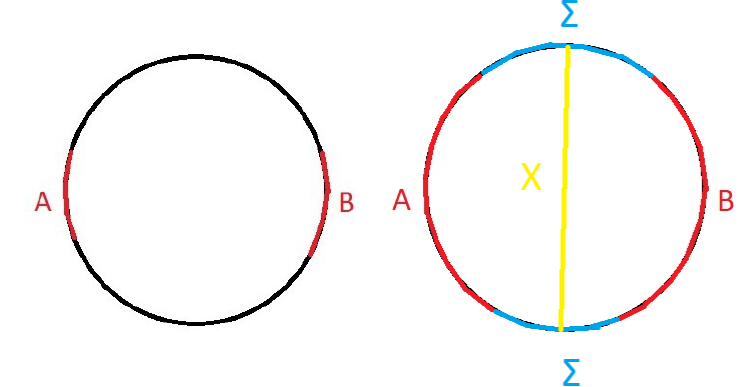
Figure 3 . Left : if A and B are small then the RT surface for A [ B is A [ B so the entanglement wedge in bulk time slice is empty. There is no neck inside entanglement wedge meaning that EoP is zero. Right : if A and B are large enough then the RT surface of A [ B is its complement (cid:6) on the circle so the entanglement wedge is the bulk hemisphere. And the neck is a semi-great circle X stretching through the